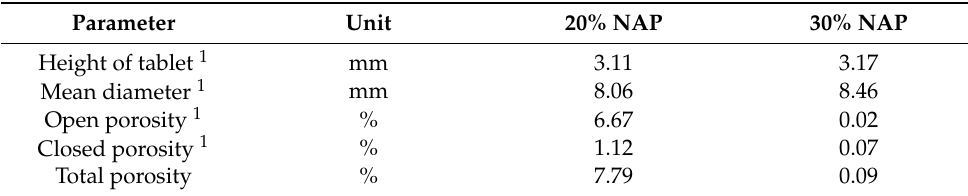
Table 1. Physical average dimensions and porosities determined by XµCT of representative 3D- printed tablets containing 20% and 30% NAP, respectively.